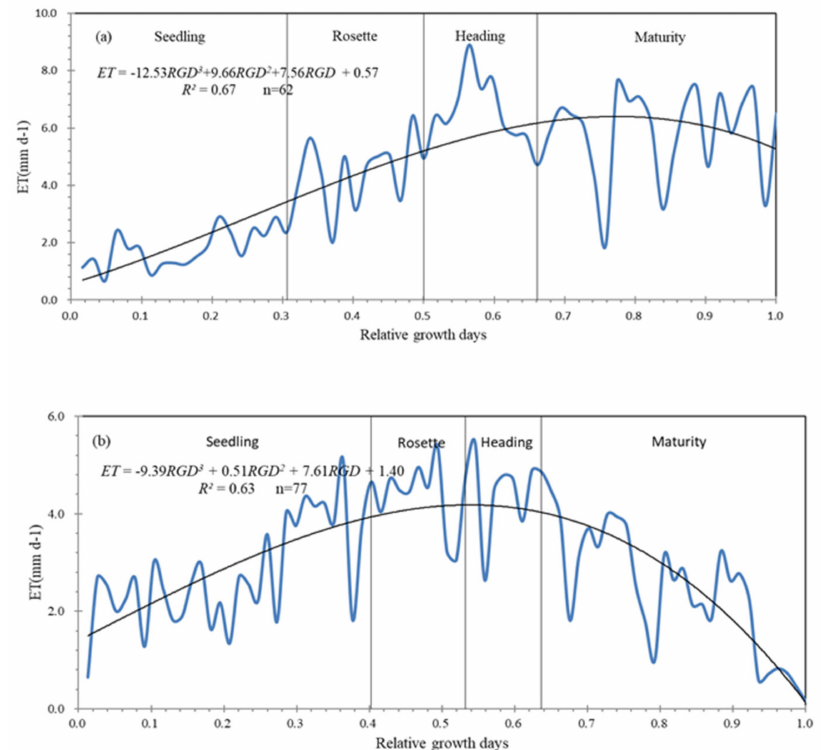
Figure 4. ( a ) Seasonal ET variation of Chinese cabbage throughout the growing period of the first crop. Relative growing days (RGDs) refer to the normalized growing days, e.g., “1” represents 61 days after sowing; ( b ) seasonal ET variation of Chinese cabbage throughout the growing period of the second crop.